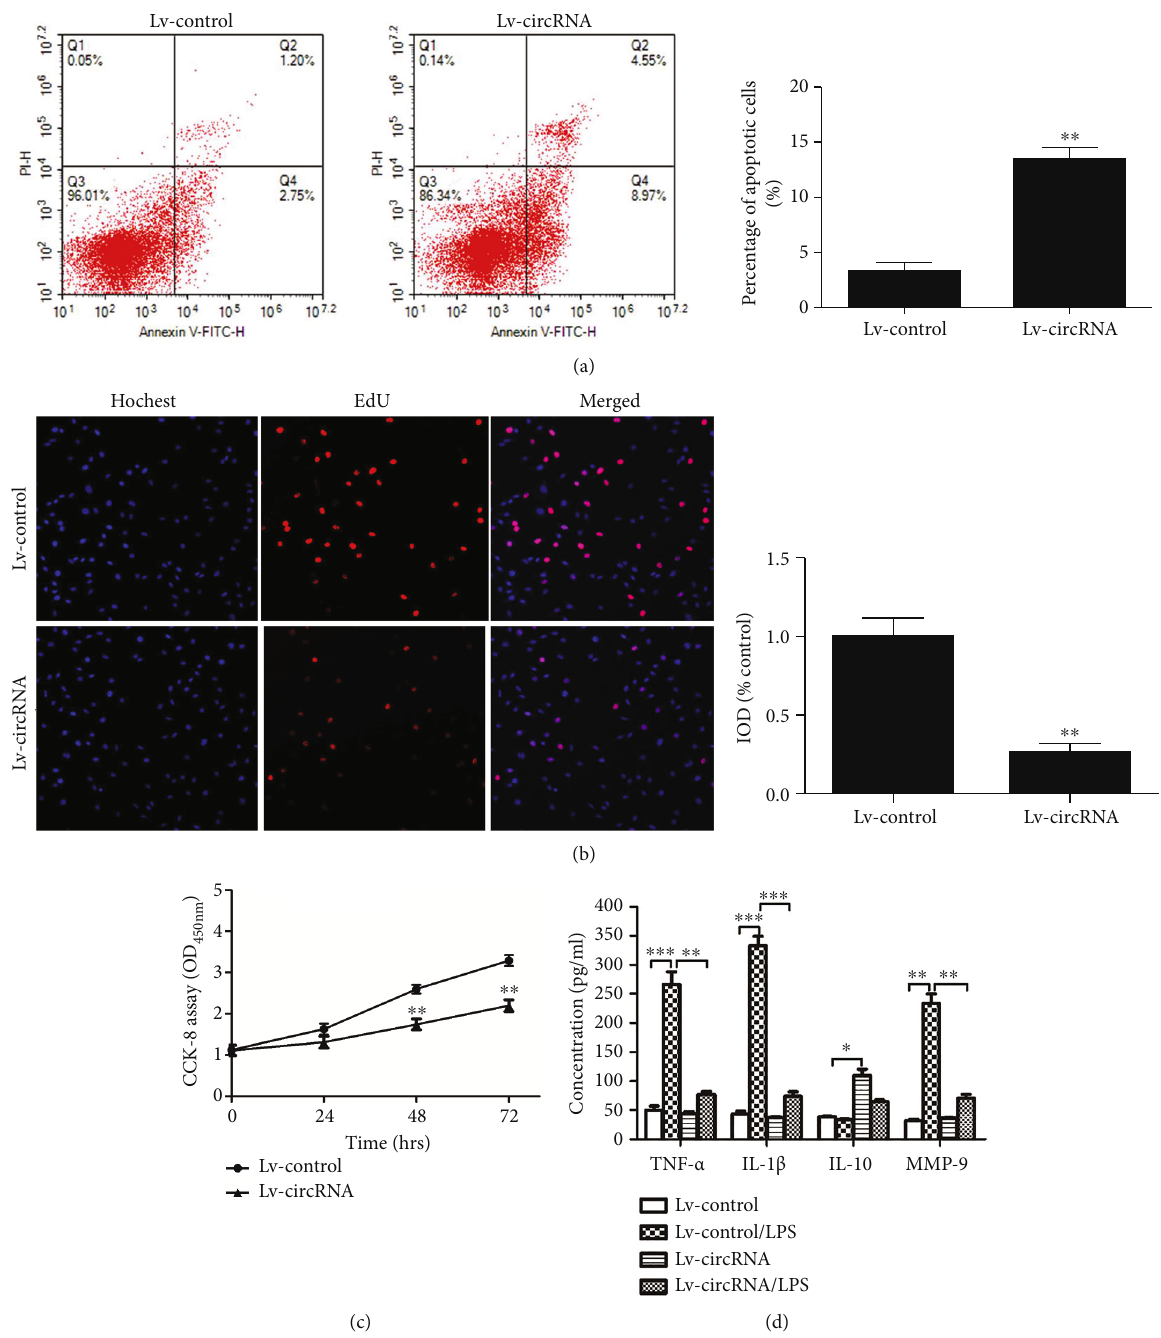
Figure 5: circRNA_17725 regulated macrophage proliferation, apoptosis, and in fl ammation. (a) Flow cytometry: Lv-circRNA_17725 O at 4h ( ∗∗ P < 0 : 01 ; n = 3 ). (b) EdU: Lv-circRNA_17725 plasmids plasmids promoted the apoptosis of macrophages induced by H 2 2 inhibited the proliferation of macrophages at 48 h (20x; ∗∗ P < 0 : 01 ; n = 3 ). (c) CCK-8: Lv-circRNA_17725 plasmids inhibited the proliferation of macrophages in a time-dependent way ( ∗∗ P < 0 : 01 ; n = 3 ). (d) ELISA: Lv-circRNA_17725 plasmids decreased TNF- α , IL- 1 β , and MMP-9 but increased IL-10 in cells cultural supernatant ( ∗ P < 0 : 05 , ∗∗ P < 0 : 01 , and ∗∗∗ P < 0 : 001 ; n = 3